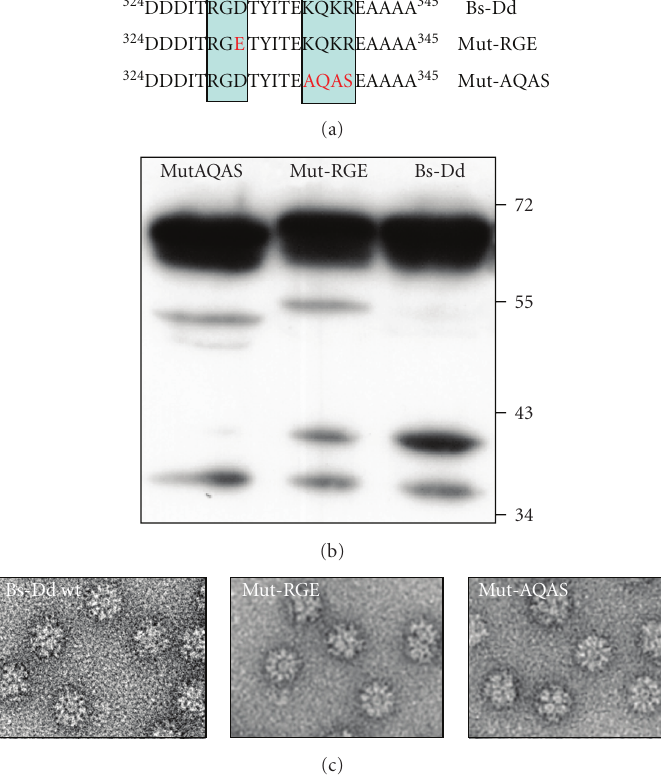
Figure 2: Mutations in the Bs-Dd RGD loop. (a) Sequence of Bs-Dd mutants in either the RGD or the basic motif (blue boxes). Mutations are indicated in red. (b) Detection of baculovirus expressed protein by western-blot using an anti-dodecahedron serum. (c) Negative staining micrographs of purified mutants and wild type Bs-Dd showing that dodecamerisation is not a ff ected by the